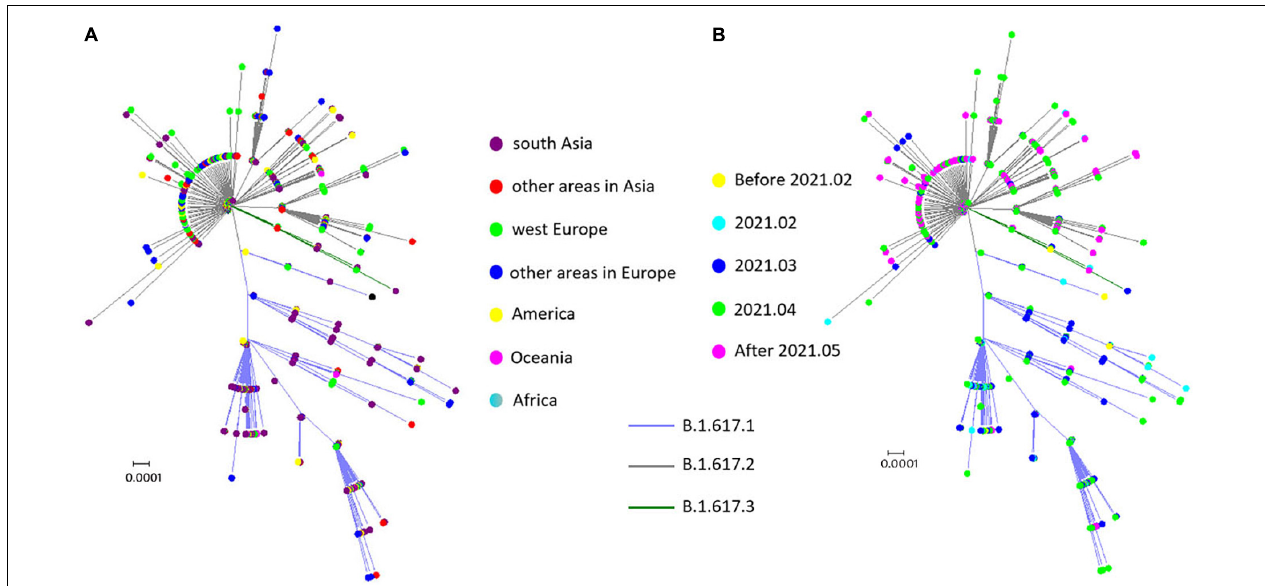
FIGURE 3 | Spatial–temporal distribution of sublineages in B.1.617. (A) Spatial distribution: no spatial specificity was found for the B.1.617.3 sublineage, B.1.617.1 was mainly localized to Southern Asia, and B.1.617.2 was distributed worldwide. (B) Temporal distribution: B.1.617.1 and B.1.617.3 were prevalent in the early stages of the pandemic, while B.1.617.2 was the predominant sublineage after March 2021.